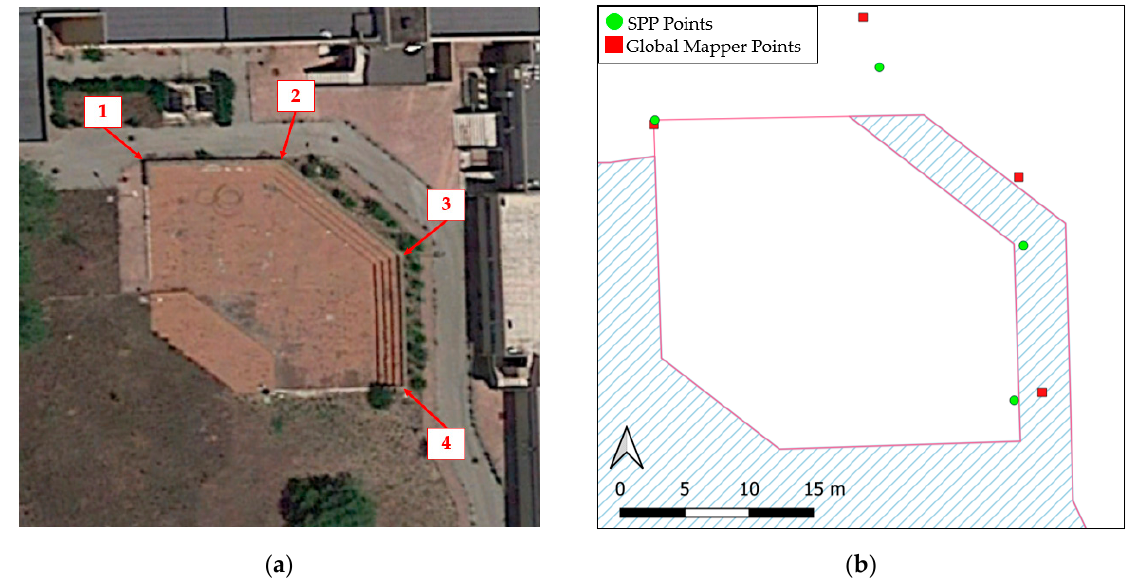
Table 13. Planimetric positioning errors achieved on the area investigated.